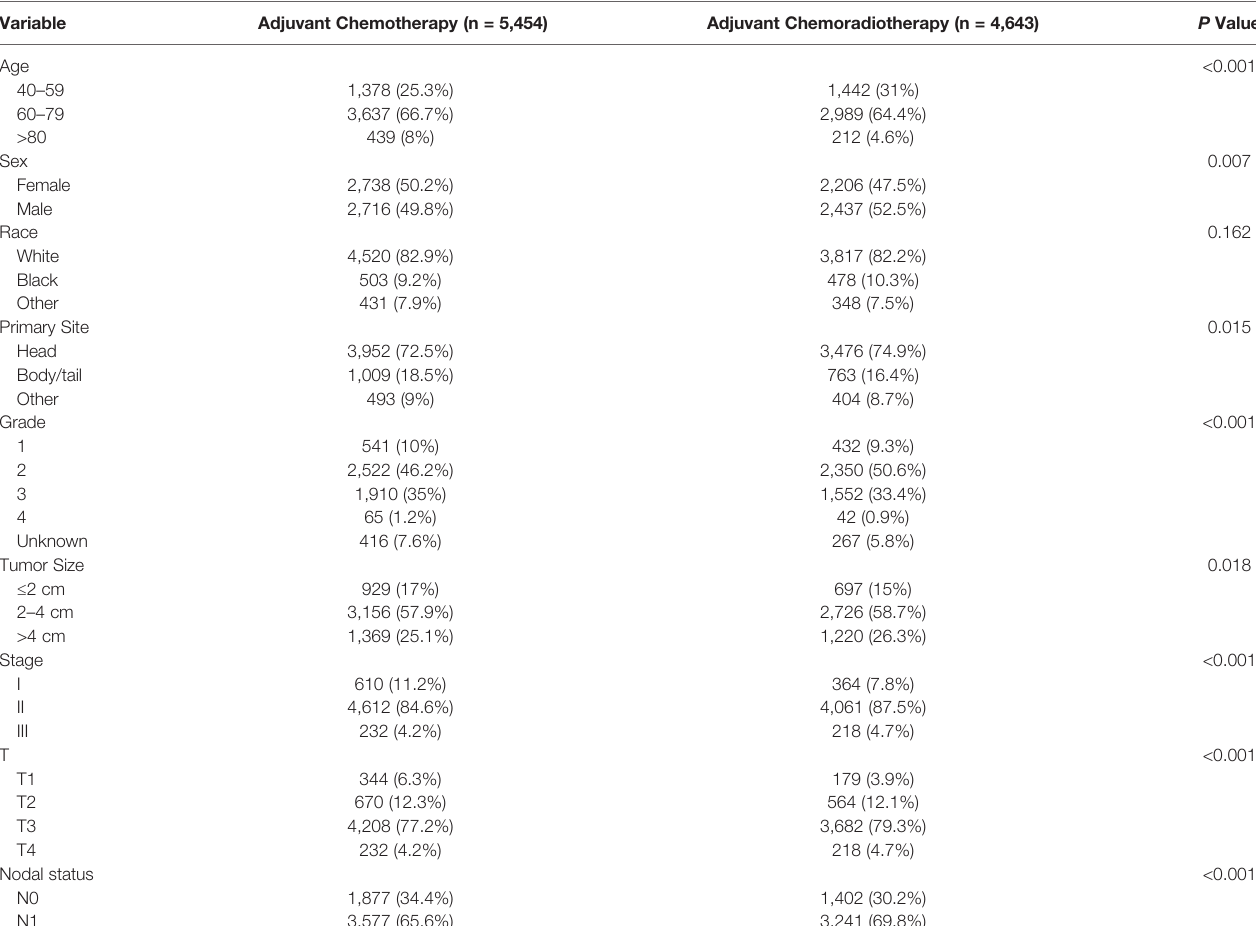
TABLE 1 | Demographic and clinicopathological features of patients receiving adjuvant chemotherapy and adjuvant chemoradiotherapy. Variable Adjuvant Chemotherapy (n = 5,454) Adjuvant Chemoradiotherapy (n =